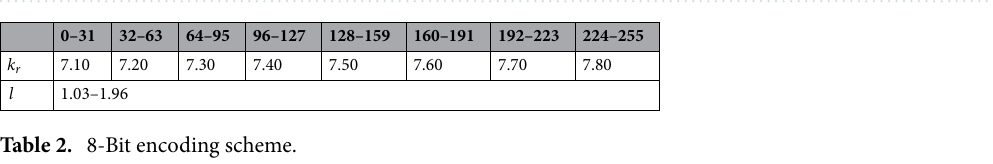
Table 2. 8-Bit encoding scheme.